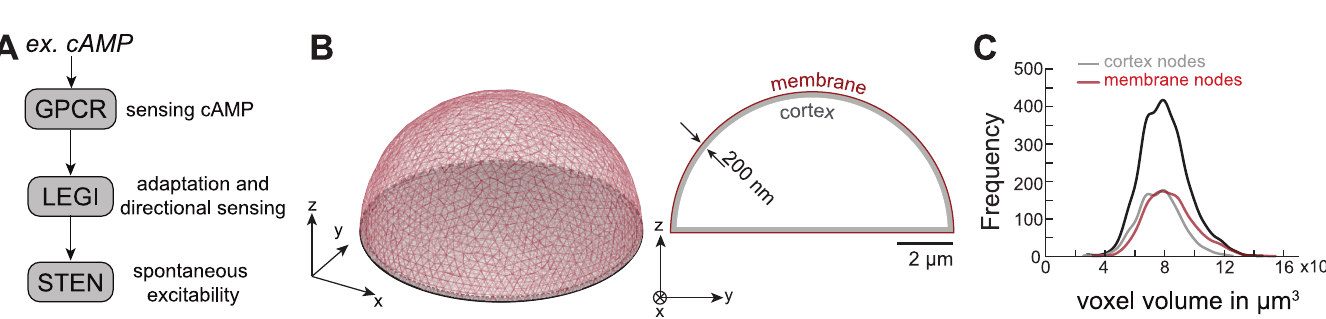
Fig 1. Model schematic and simulation domain. (A) Reaction scheme adopted in the present study involves a receptor module describing GPCR (G-Protein Coupled Receptor) dynamics, a LEGI (Local Excitation and Global Inhibition) module that provides adaptation and directional sensing, and a STEN (Signal Transduction Excitable Network) that describes the excitable behavior of the cell. (B) Isometric (left) and cross-sectional side view (right) of the hemispherical simulation domain of radius 5 μ m and thickness of 200 nm. The outer surface is the membrane and the interior of the shell is the cortex.(C) Frequency distribution of all the nodal volumes (black), membrane nodes (red) and cortex nodes